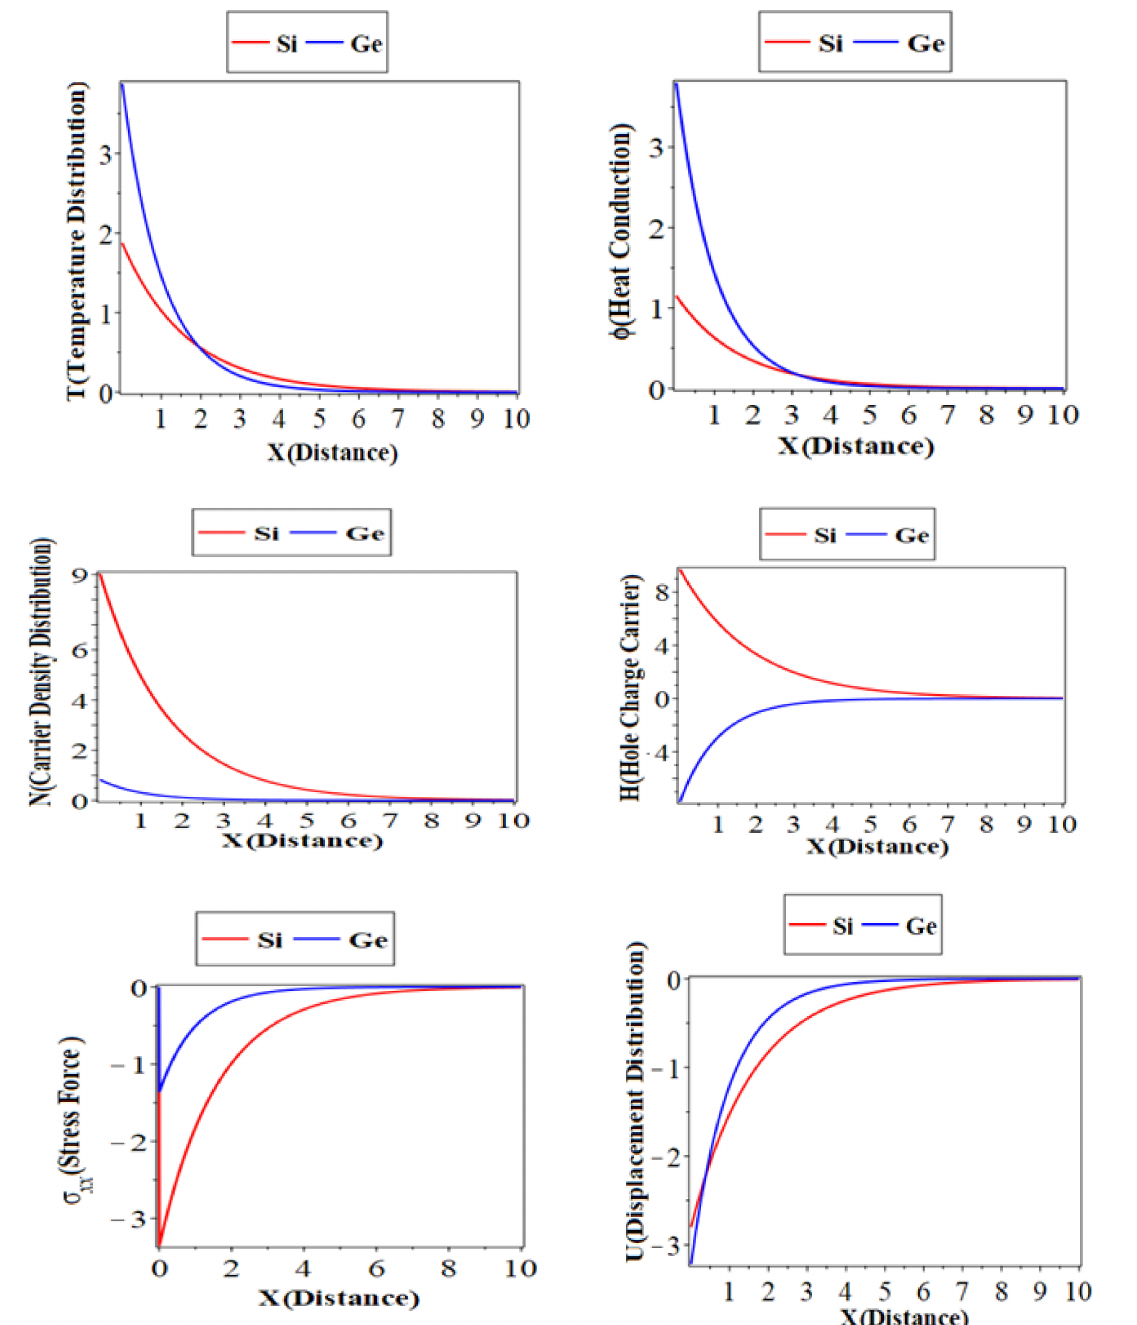
Figure 5. The comparison between Si and Ge materials of physical field distributions with distance when ε 1 = 0.001, τ θ = 0.02 and τ q =